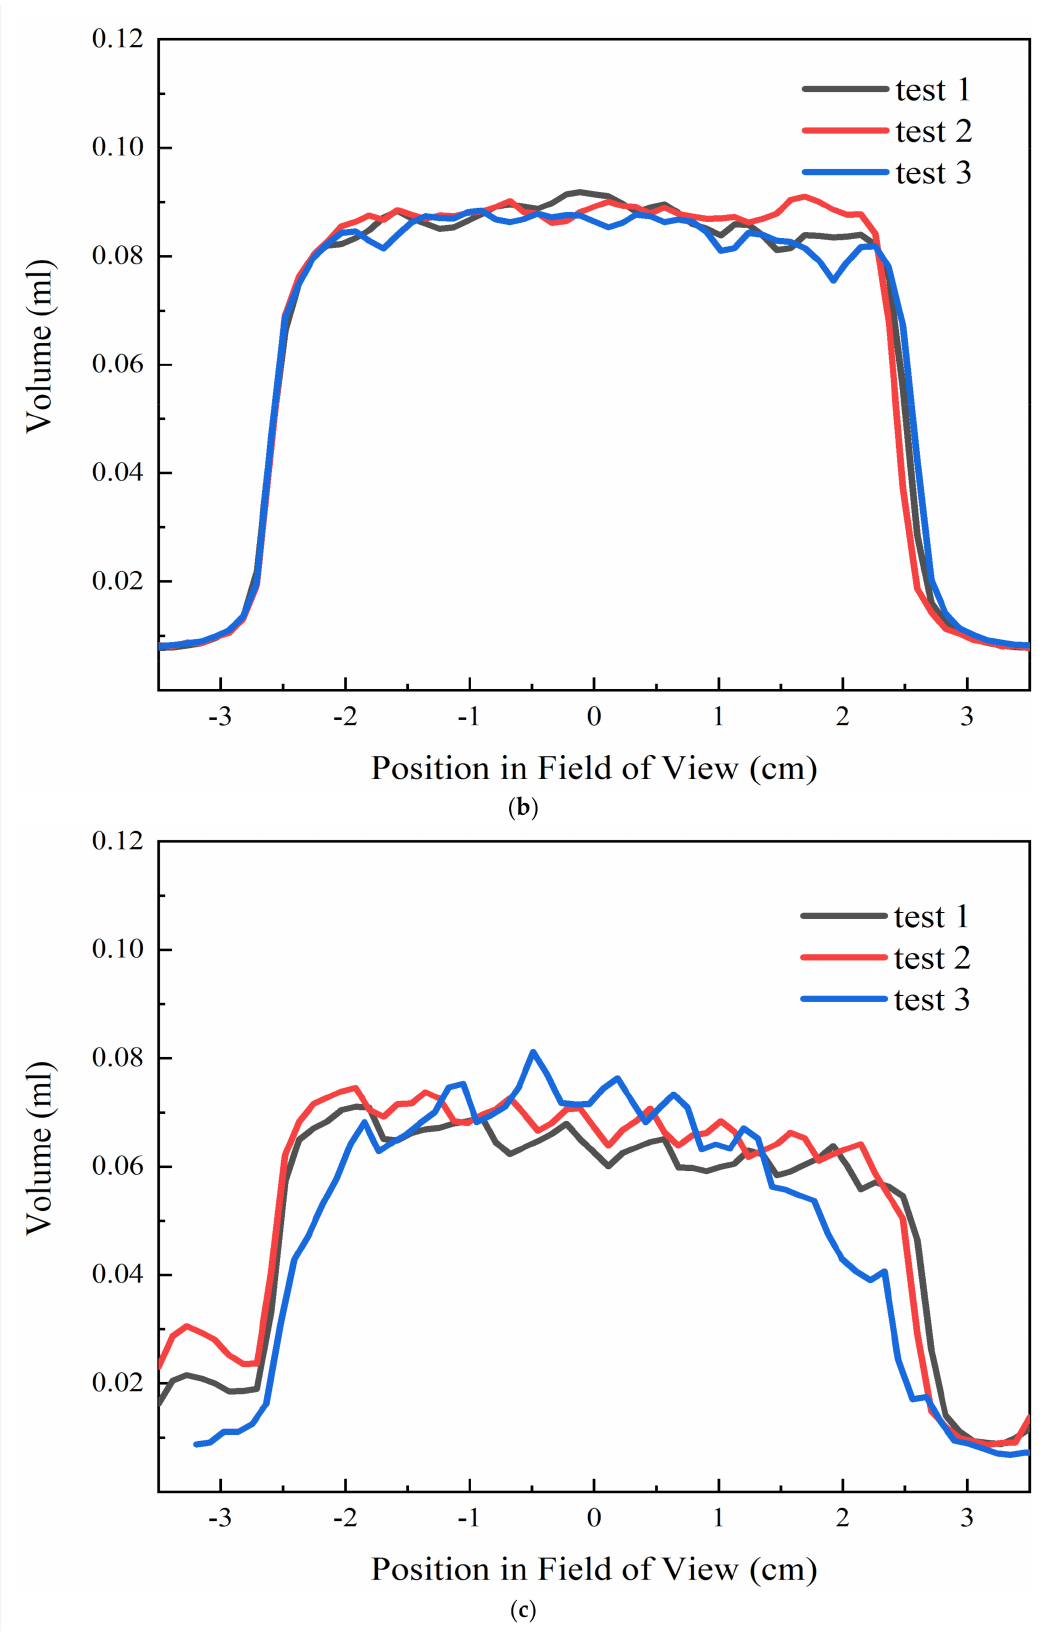
Figure 4. Water distribution of each type of sample: ( a ) water distribution of sample 1, ( b ) water distribution of sample 2, ( c ) water distribution of sample